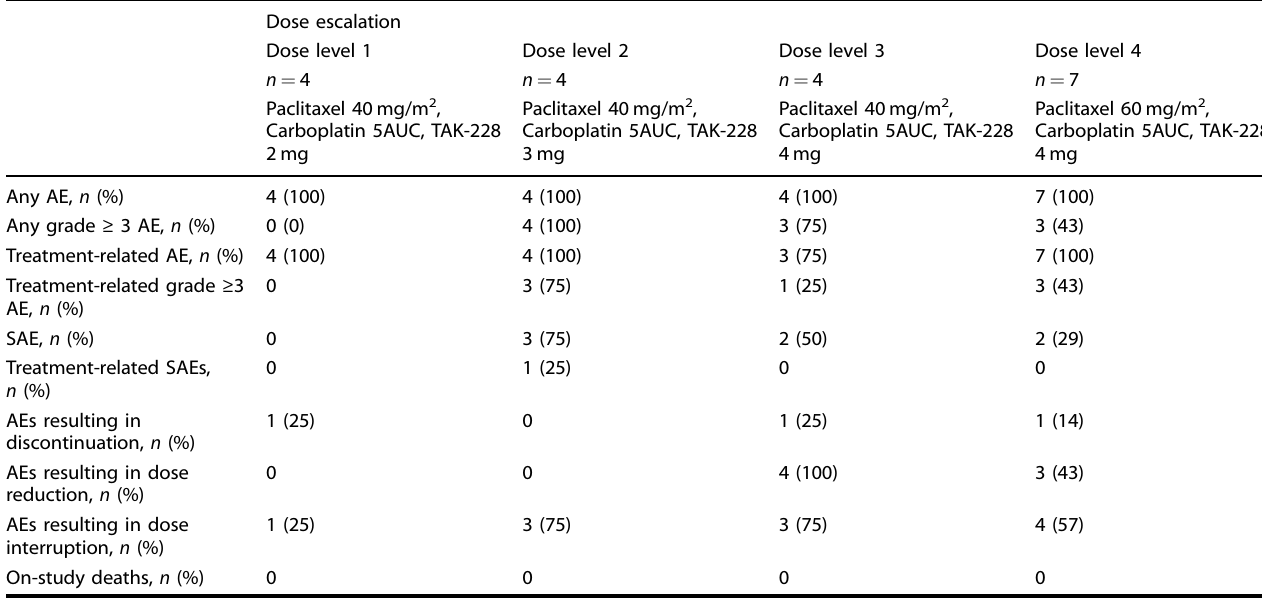
Table 3. Overall safety pro fi